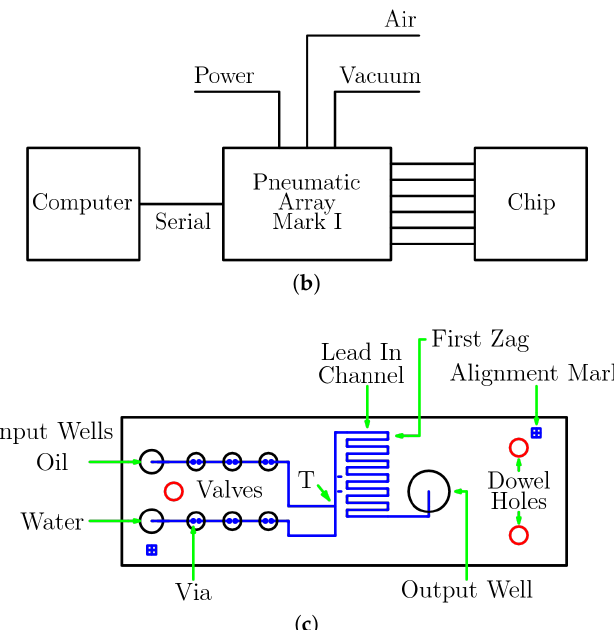
Figure 1. ( a ) The fabrication process cuts and pattern pieces of PMMA: one with channels and vias (A.1), and another with cut-outs alone (B.1). The pieces are engraved, cut and thermally bonded (Steps 2, 3), and then, a layer of HDPE is applied and laser patterned (A.4, A.5). TPU tape is then applied (A.6), and two capping layers are then added using double-sided tape. The outermost capping layer contains a brass fitting that is directly connected for pneumatic actuation. ( b ) As depicted, the overall system consists of a commercially-manufactured pneumatics control system (Pneumatic Manifold Mark I, a shoe-box-sized instrument from Droplabs) that connects directly to the chip itself and to a laptop computer via a serial cable. ( c ) A top-view of the chip design (76.2 mm × 25.4 mm) containing microchannels (blue lines), three wells (larger black circles), 12 vias (blue dots) within six microvalves (smallest black circles) that form the two peristaltic pumps. The microchannels link the reagent reservoirs (input wells, one of oil, one of coloured water) to the pumps and a T-intersection followed by a zig-zag structure and a waste well (output well). The design also includes dowel holes (red circles), which are used to align the layers of the chip during